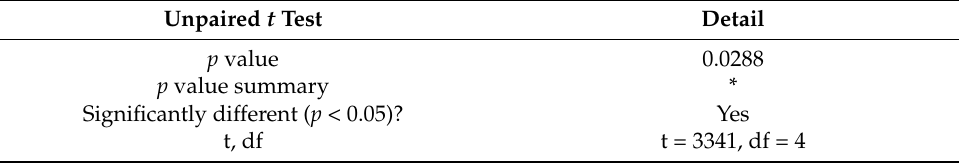
Table 1. Statistical analysis regarding differences in the stone colonization/proliferation area by P. sesnandensis in the absence and in the presence of carrageenan extracts (control vs. treatment). Unpaired t Test Detail p value 0.0288 p value summary * Significantly different ( p <